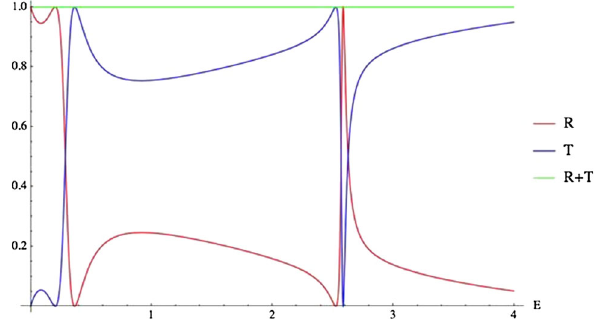
Fig. 2 Reflection ( R ) and transmission ( T ) coefficients and their sum- mation plotted in terms of energy